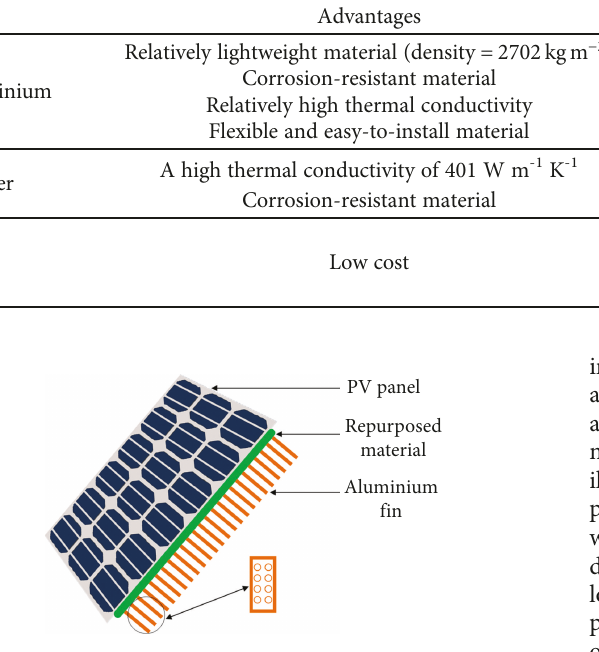
Figure 2: Schematic of a PV panel fi tted with repurposed materials and fi